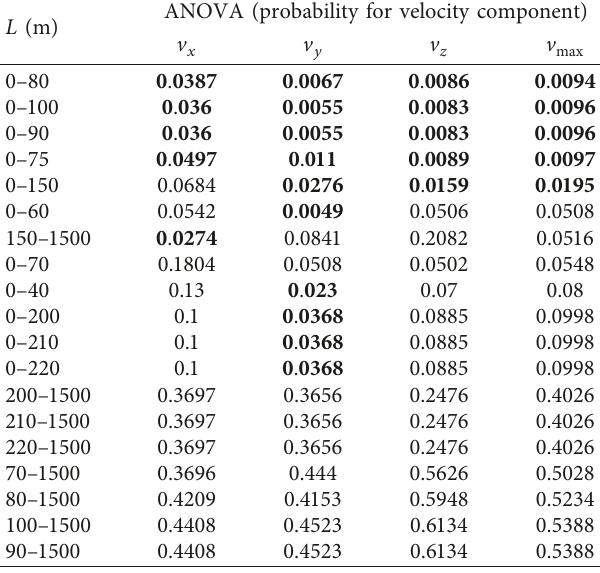
Table 2: Summary of variability analysis results (Prob > F ) with a 10-step shift of L